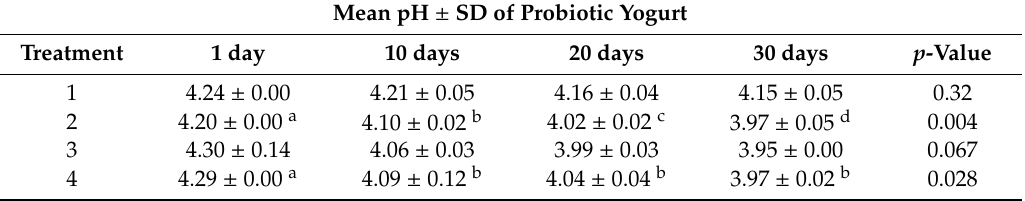
Table 4. Mean pH (Mean ± SD) of probiotic yogurt treatments containing Lactobacillus rhamnosus GR-1 following 1, 10, 20, and 30 days of refrigerated storage.